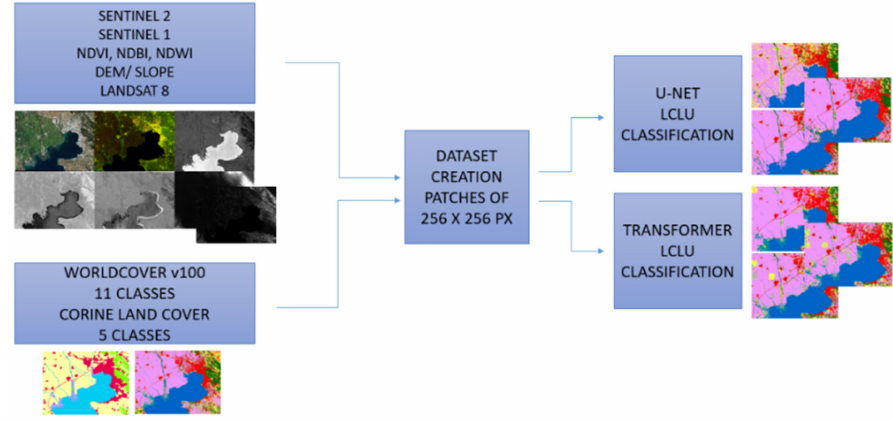
Figure 3. Machine Learning Pipeline.